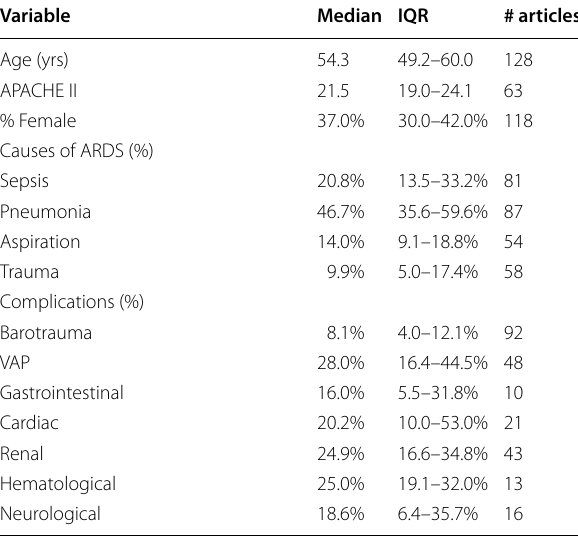
Table 1: Summary of data collected from included